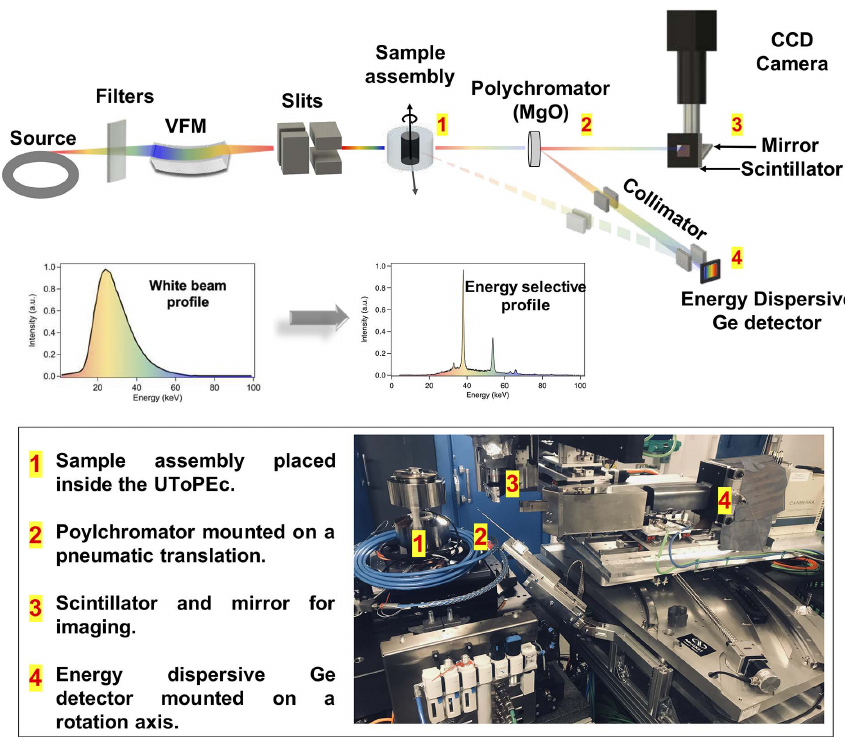
Figure 1 Experimental setup on the white beam station of the PSICHE beamline at SOLEIL (see also Section S1 of the supporting information). A white beam spectrum is produced from an in-vacuum wiggler (source) and different sets of low-energy absorbers (filters). A vertically focusing mirror (VFM) focuses the beam in the vertical direction which is furthermore collimated on the sample horizontally and vertically using two pairs of slits. The sample is placed in the UToPEc (Ultrafast Tomography Paris Edinburgh Cell) and mounted on a set of three translation stages allowing its movement in the three Cartesian coordinates, and on a rotation axis for X-ray computed tomography. The upper illustration and corresponding photograph represent the three setups that can be used quasi simultaneously in the scope of this article: (i) Fast X-ray tomography and imaging where the pink X-ray beam attenuated by the sample is converted to visible light by a scintillator and transmitted to the CCD camera using different sets of optics. (ii) Energy-dispersive X-ray diffraction is achieved through acquisition of scattered photons by the energy-dispersive Ge detector, mounted on a rotation axis and focused on the sample using two pairs of slits, making it possible for combined angle- and energy-dispersive X-ray diffraction (CAESAR: combined angle and energy-dispersive structural analysis and refinement). The pathway of the X-ray beam is dashed. (iii) The X-ray absorption method is achieved via the insertion of a pellet of dried fine powder of MgO downstream of the sample, and the displacement of the collimation slits of the Ge detector to acquire the X-ray diffraction pattern of MgO. The XRD pattern of MgO, represented in the insert, shows an energy-selective profile acting as a